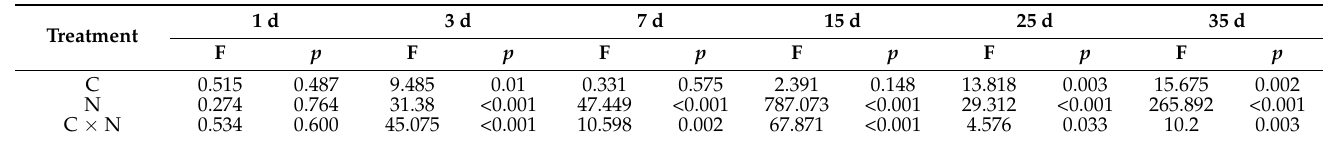
Table 4. ANOVA of the effects of returning straw and the nitrogen application rate on the nitrification rate of nitrogen in saline–alkaline soil.